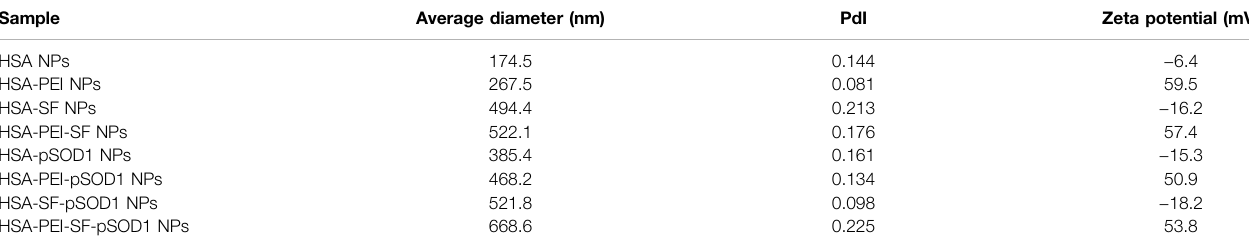
TABLE 1 | Average DLS diameter, polydispersity index (PdI), and zeta potential of the HSA nanoparticles.